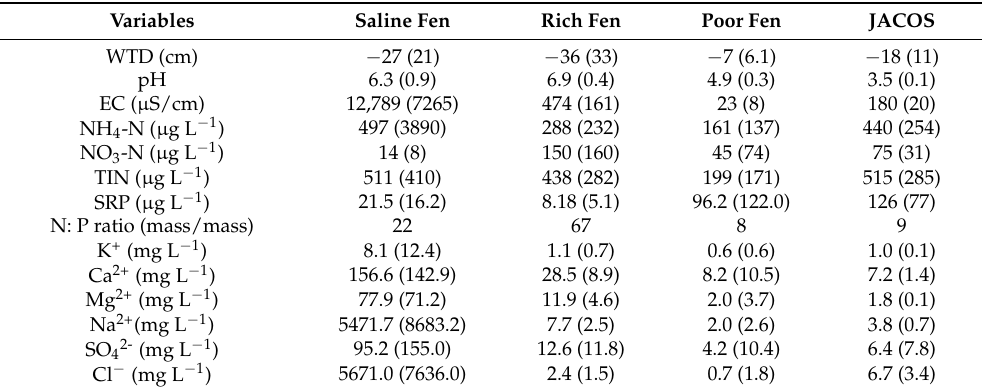
WTD: Water table depth; EC: Electrical Conductivity; TIN: Total Inorganic N; SRP: Soluble Reactive